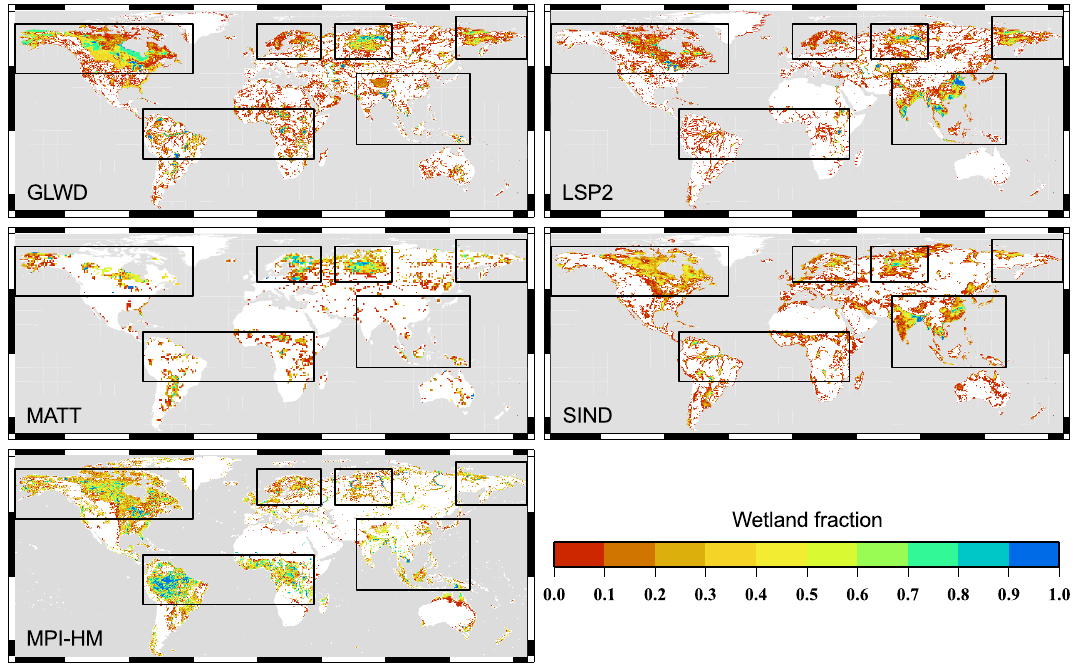
Fig. 5. Observed (top, middle) and simulated (bottom) maximum wetland distribution. The colors indicate the wetland fraction for every 0.5 ◦ grid cell. The black boxes highlight regions of pronounced wetland occurrence.